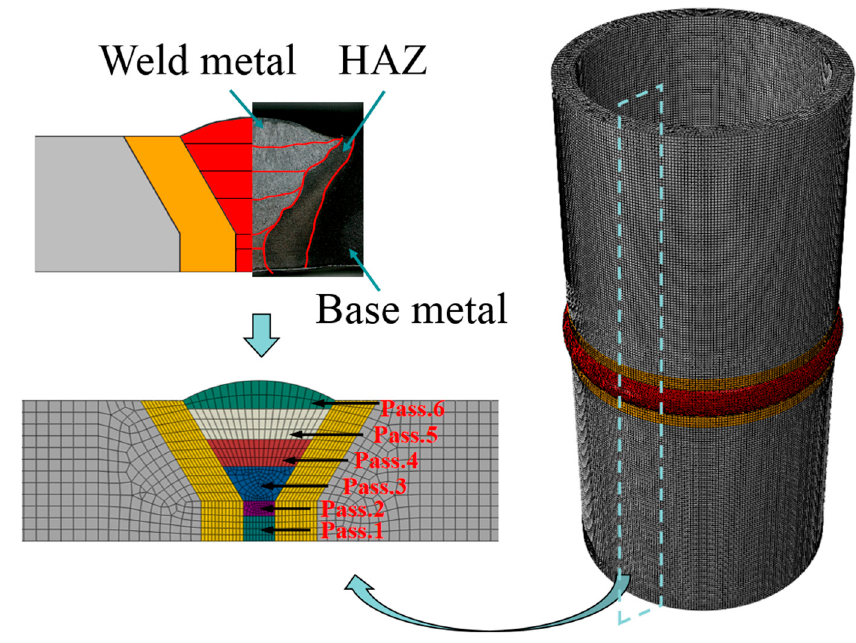
Figure 6. Finite element model and meshing.